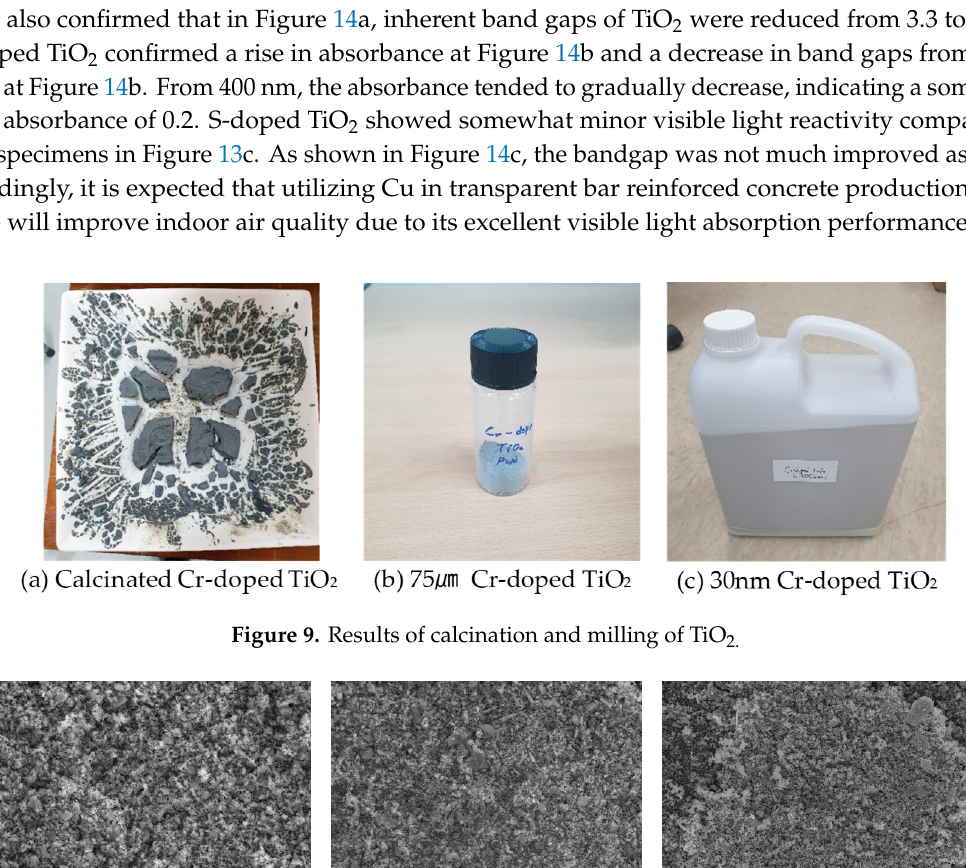
Figure 10. SEM (Scanning electron microscope) microstructure images of doped TiO 2 specimens.